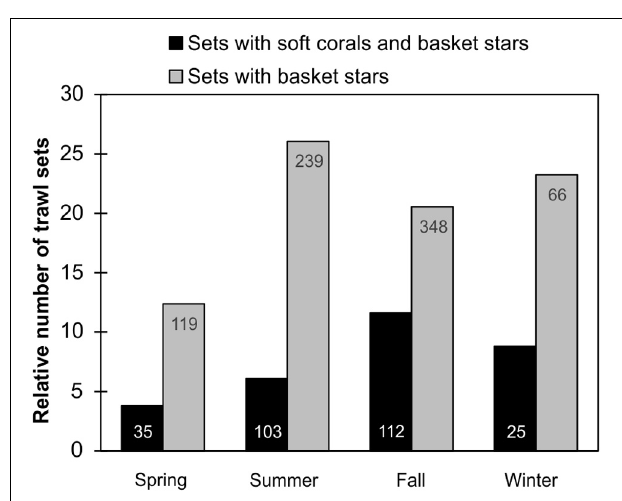
FIGURE 11 | Relative proportion of DFO trawl sets with basket stars and Nephtheidae soft corals, and sets with basket stars per season in the Grand Banks region (pooled 2011–2017). Total number of sets with basket star and coral co-occurrence is shown on bottom of bars, and number of sets with basket stars is shown on top of